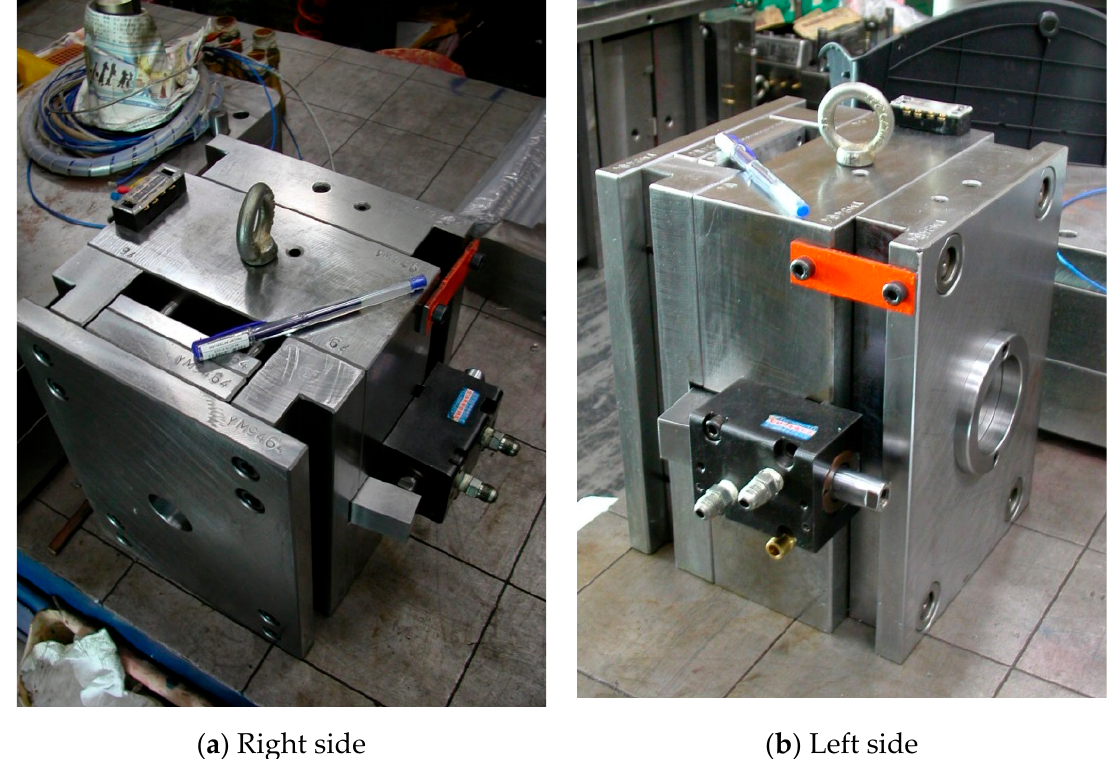
Figure 4. Actual photograph of this mold of VCRHCS.